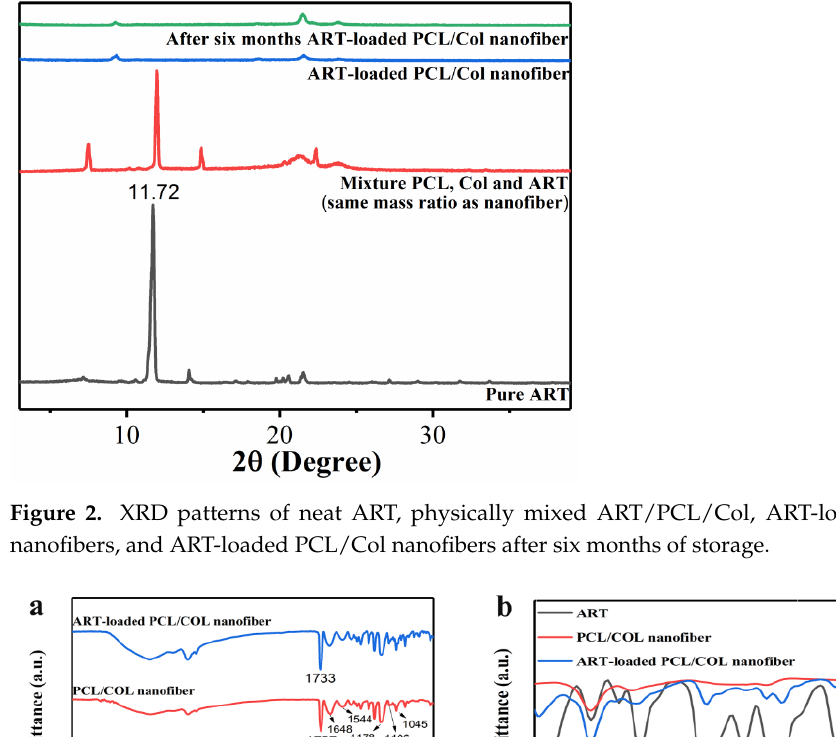
Figure 3a: the peak at 1737 cm − 1 corresponds to the tensile vibration of C=O in ART [48]. PCL exhibited the characteristic peaks at 1170 cm − 1 (stretching band of C-O); 1048 cm − 1